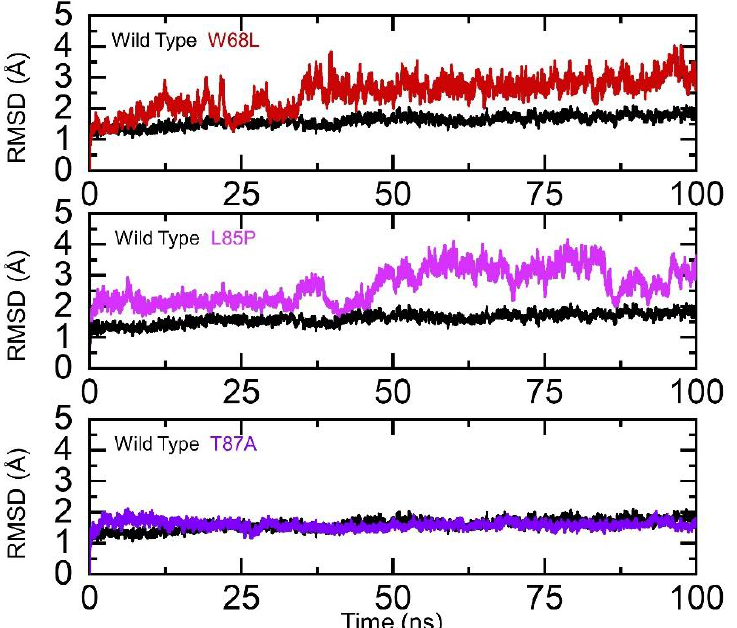
Figure 2. Stability analysis of the wildtype and W68L, L85P, and T87A mutants. The wildtype is shown as black, W68L (red), L85P (magenta), and T87A (purple).